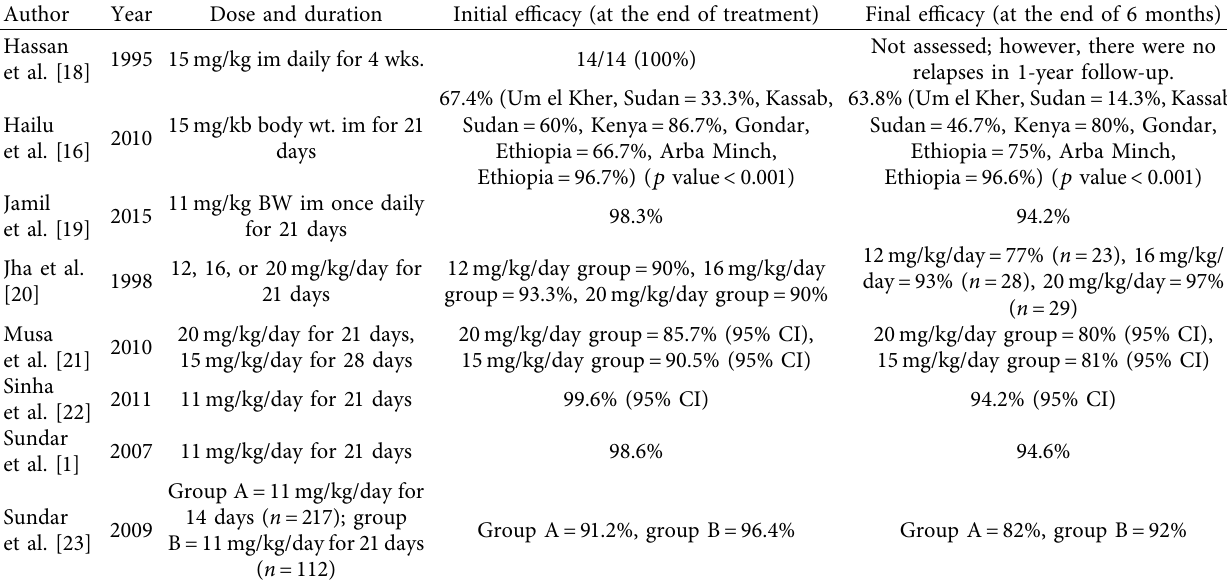
Table 2: Efficacy of injectable